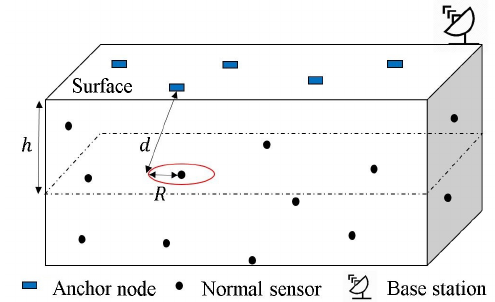
Figure 1. Deployment scenario for 3D localization